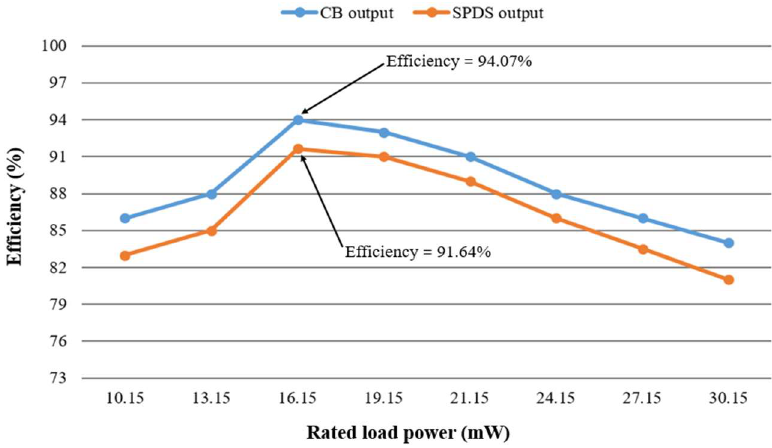
Figure 17. Measured electrical outputs of the SPDS: ( a ) Output voltage. ( b ) Load power.